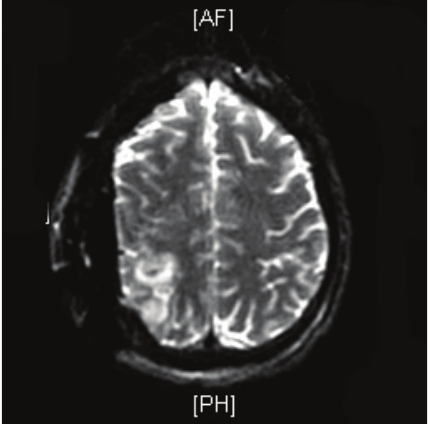
Figure 3: Diffusion weighted magnetic resonance image demon- strating right parietal